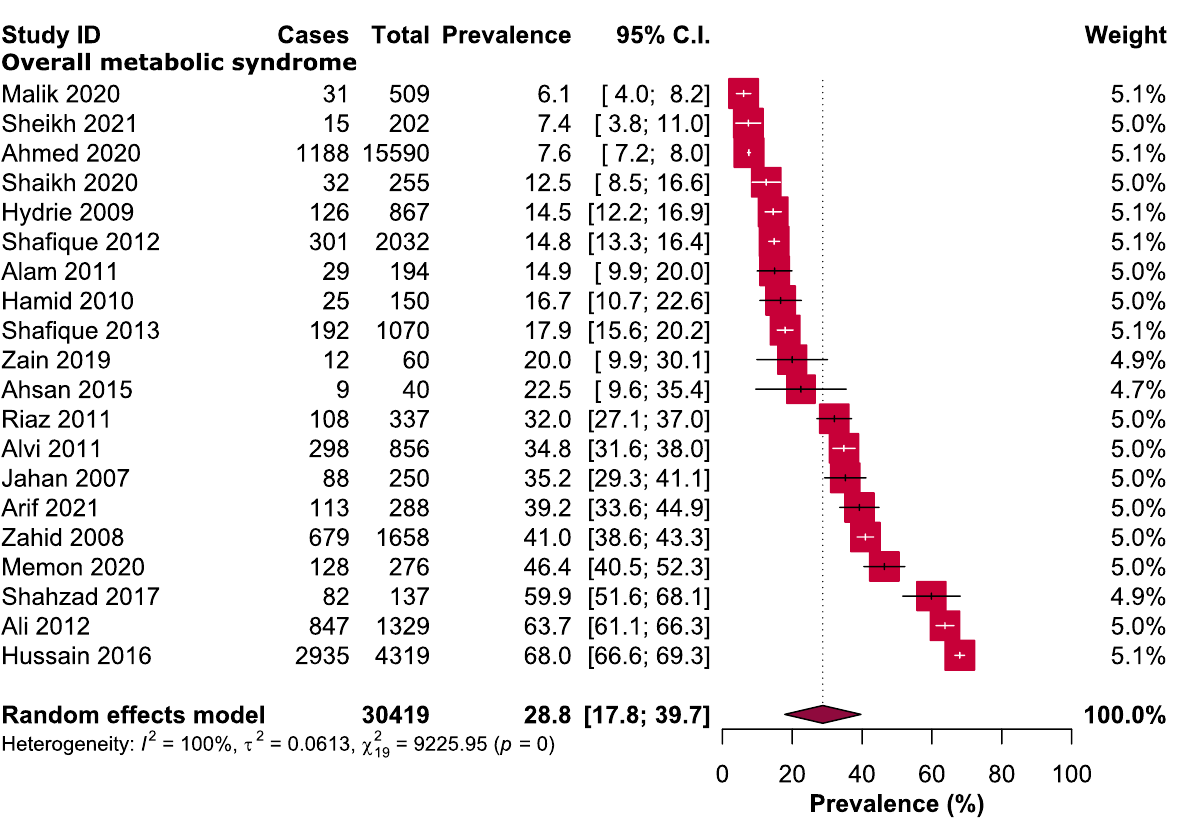
Figure 2. Prevalence of metabolic syndrome in Pakistan.